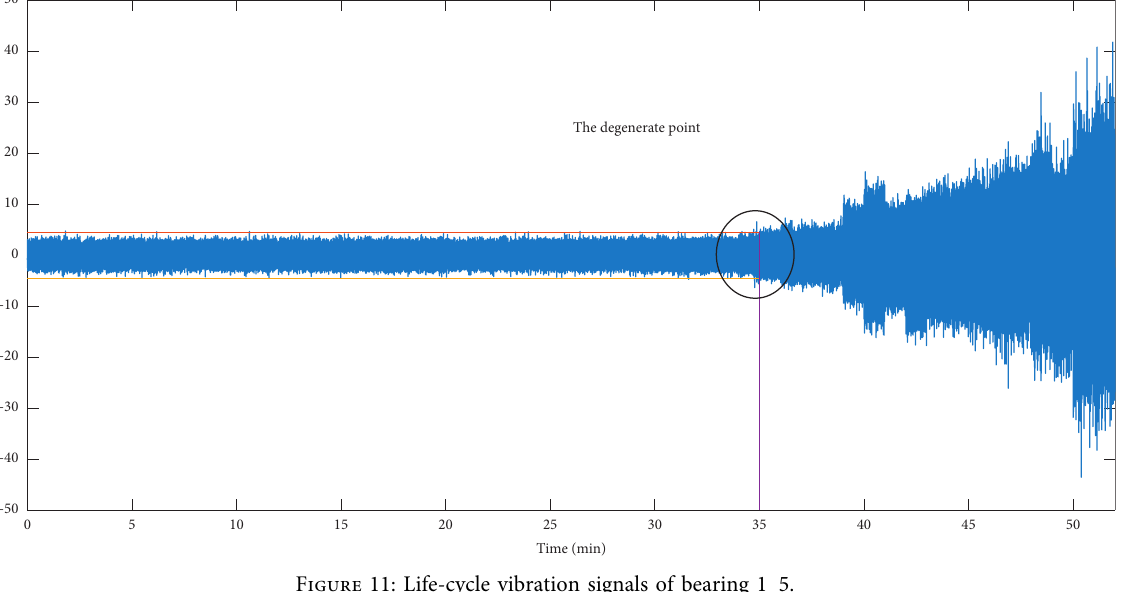
Figure 11: Life-cycle vibration signals of bearing